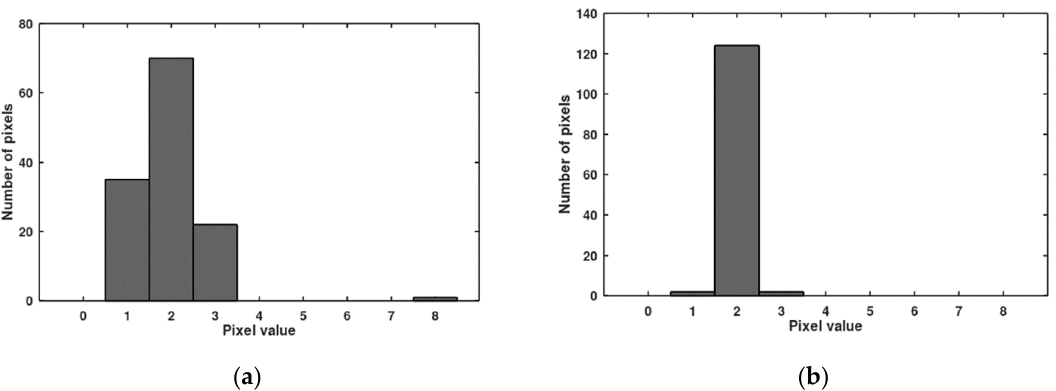
Figure 7. Distribution of dark signal responses before ( a ) and after ( b ) the offset correction for the measured imager (containing 128 pixels).